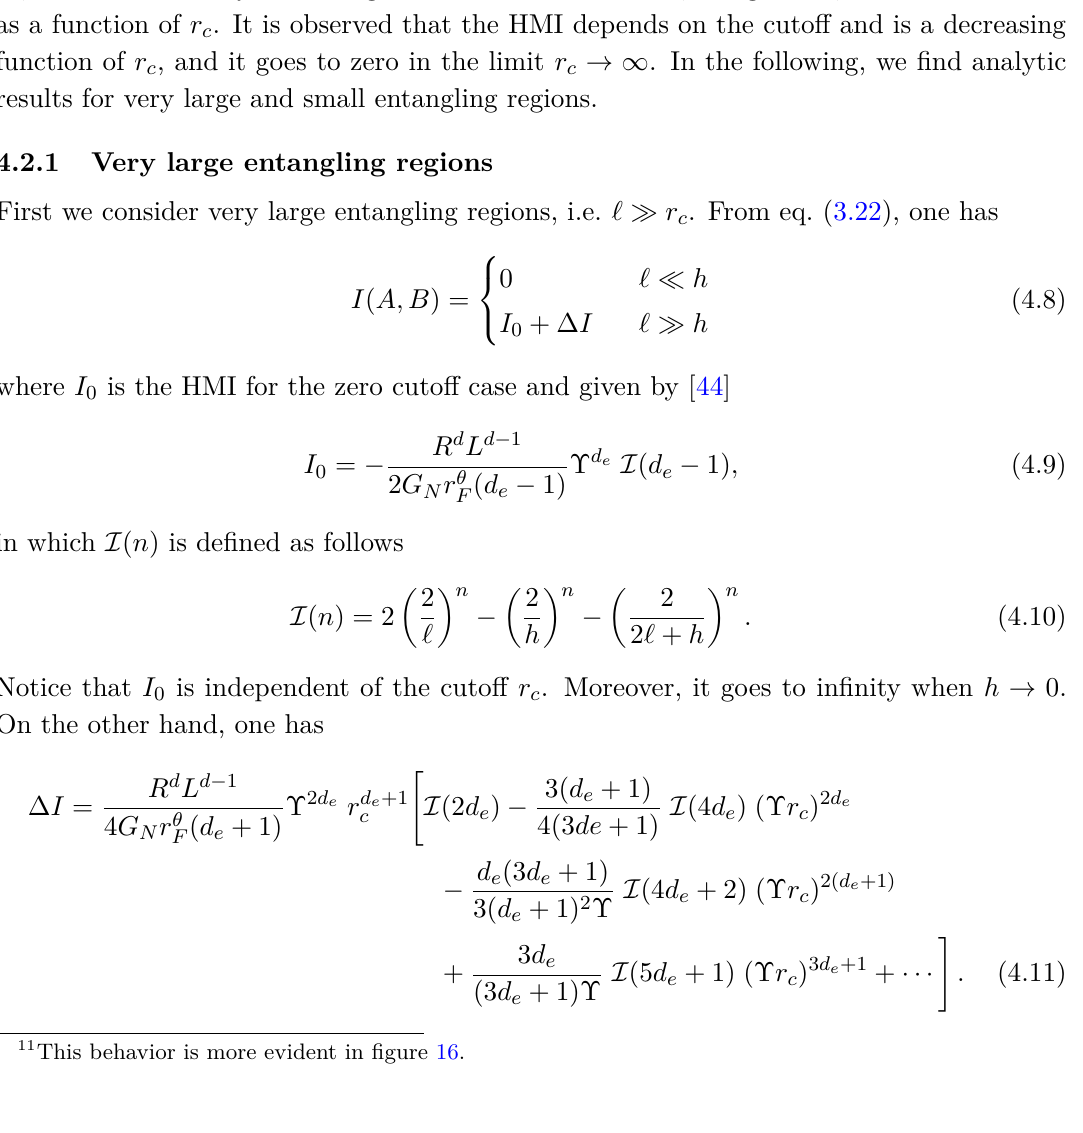
, such that it goes c